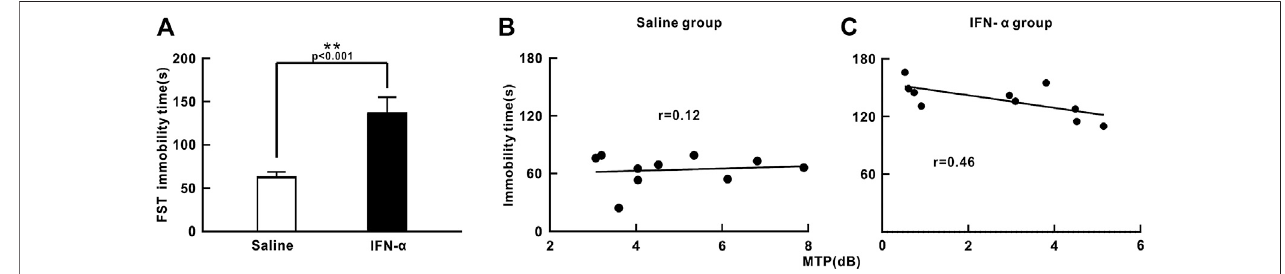
FIGURE 5 | Effect of IFN- α treatment on immobility time during FST and correlation with ASSR. (A) IFN- α treatment increases immobility time in mice. n (cid:1) 10 mice per group. Bars represent the mean ± SE. ** p < 0.01, Student ’ s t-test. (B) No correlation between immobility time and MTP of ASSR in the saline injection group. (C) Signi fi cant correlation between immobility time and MTP of ASSR in the IFN- α injection group.